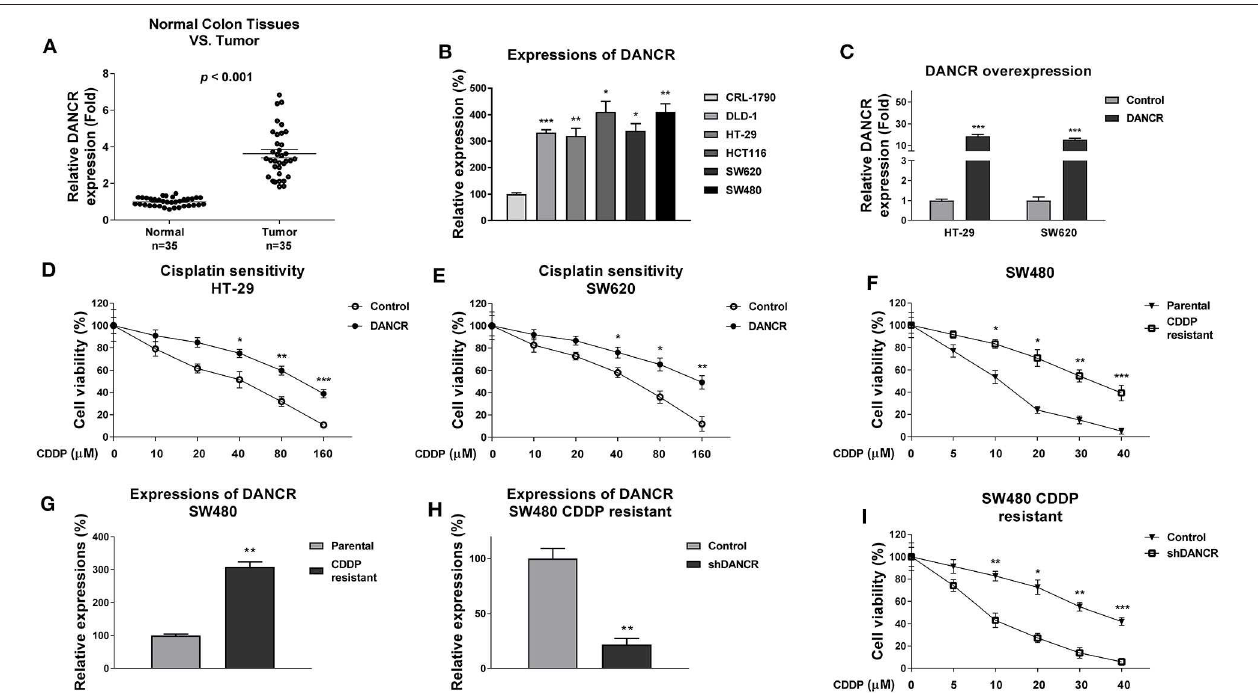
FIGURE 1 | LncRNA DANCR is upregulated in colon cancer and contributes to cisplatin resistance. (A) Quantitative RT-PCR results of the DANCR expressions in 35 normal colon tissues and 35 tumor tissues. (B) Quantitative RT-PCR results of the DANCR expressions in normal colon epithelial cell and five colon cancer cells. (C) DANCR overexpression vector or control vector was transfected into HT-29 and SW620 cells for 48h. The expressions of DANCR were detected by qRT-PCR. (D) HT-29 and (E) SW620 cells with control or DANCR overexpression vector transfection were treated with cisplatin at the indicated concentrations for 48h. Cell viability was measured by MTT assay. (F) Establishment of cisplatin-resistant cell line from SW480 cells. The resistance was assessed by treatments with cisplatin at the indicated concentrations. (G) The expressions of DANCR were detected from SW480 parental and cisplatin-resistant cells by qRT-PCR. (H) SW480/CDDP R cells were transfected with control shRNA or DANCR shRNA for 48h, the expressions of DANCR were detected by qRT-PCR. (I) The above cells were treated with cisplatin at 0, 5, 10, 20, 30, or 40 µ M for 48h; cell viabilities were measured by MTT assay. Data are presented as mean ± SD. * p < 0.05, ** p < 0.01, and *** p <